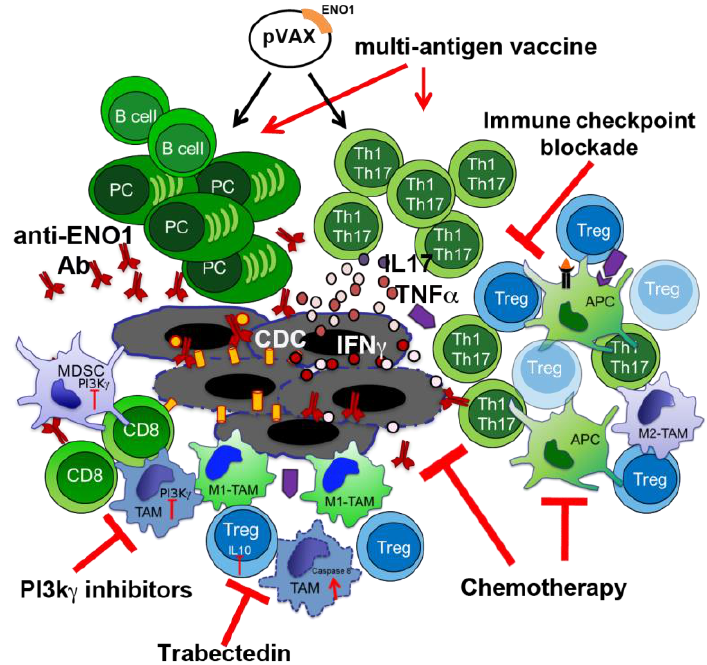
Figure 4. ENO1 DNA vaccination and potential combo partners. Cartoon shows the multiple effects of potential combinatory treatments (red arrows) with ENO1 DNA vaccination (black arrows) on the antitumor immune response.